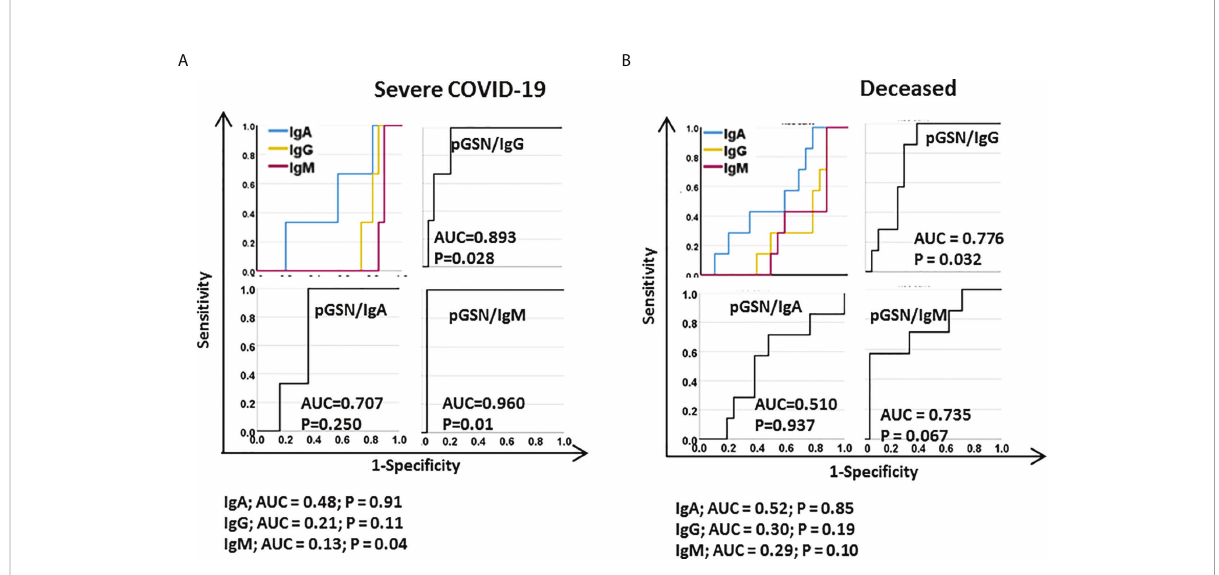
FIGURE 4 pGSN/IgG and pGSN/IgM are strong predictors of worst COVID-19 outcomes. ROC curves were used to assess the test performances of IgG, IgA, IgM, pGSN/IgG, pGSN/IgM and pGSN/IgA in predicting (A) disease severity and (B)